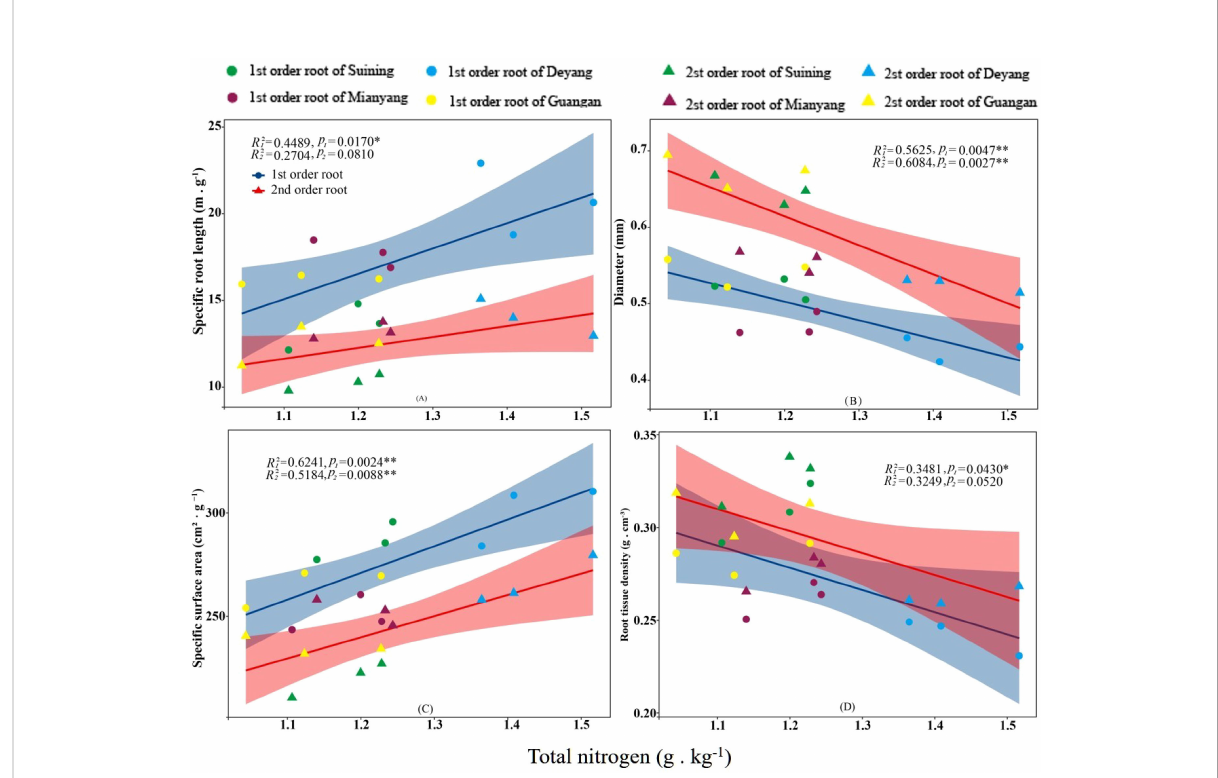
FIGURE 2 Effects of soil total nitrogen on speci fi c root length, root diameter, speci fi c root surface area, and root tissue density at four research sites. R 12 and R 22 represent coef fi cients of determination for regressions of fi rst- and second-order fi ne roots *and **indicate signi fi cance at p < 0.05 and p p- values indicating signi fi cance of regressions with fi rst- and second-order fi ne roots, respectively. The p < 0.01, respectively. p 1 and 2 are shaded part is the con fi dence interval of the fi tting line, regimes (n = 3 per